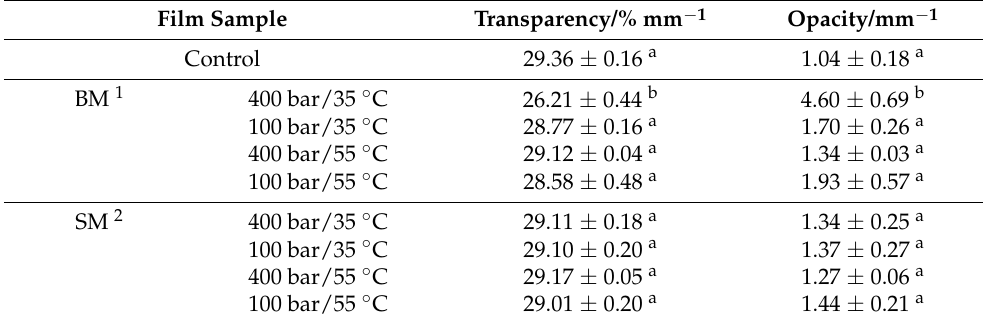
Table 2. UV barrier properties of control film and films impregnated under different